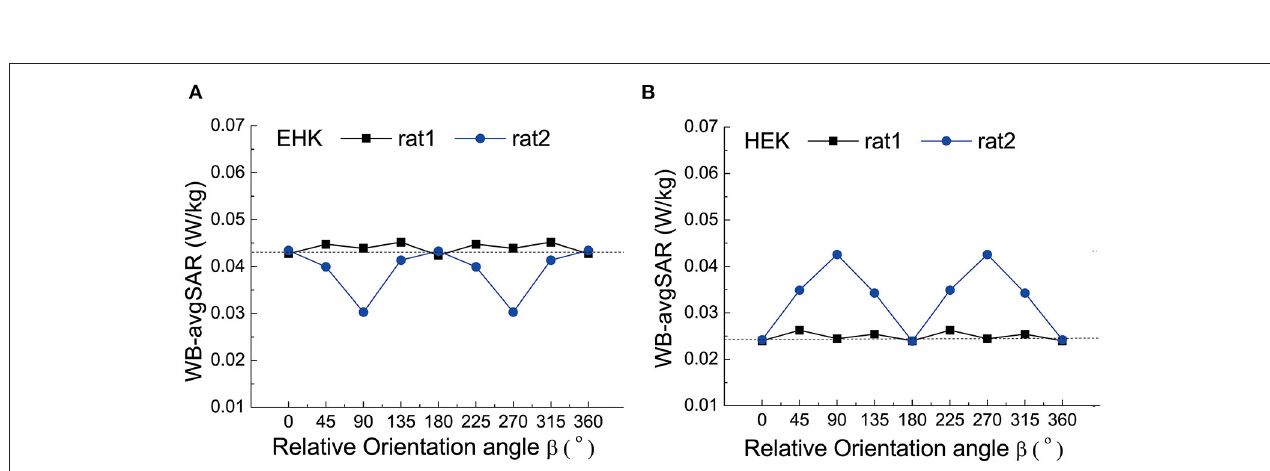
Frontiers in Public Health |